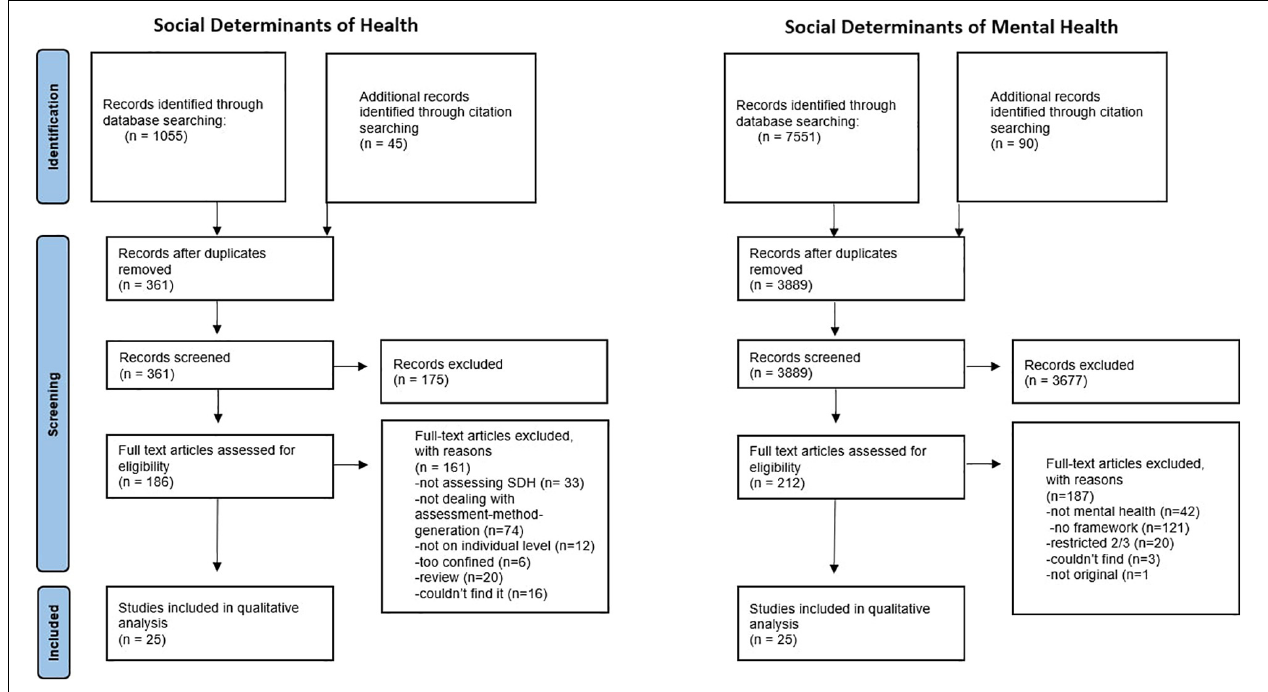
FIGURE 1 | Prisma